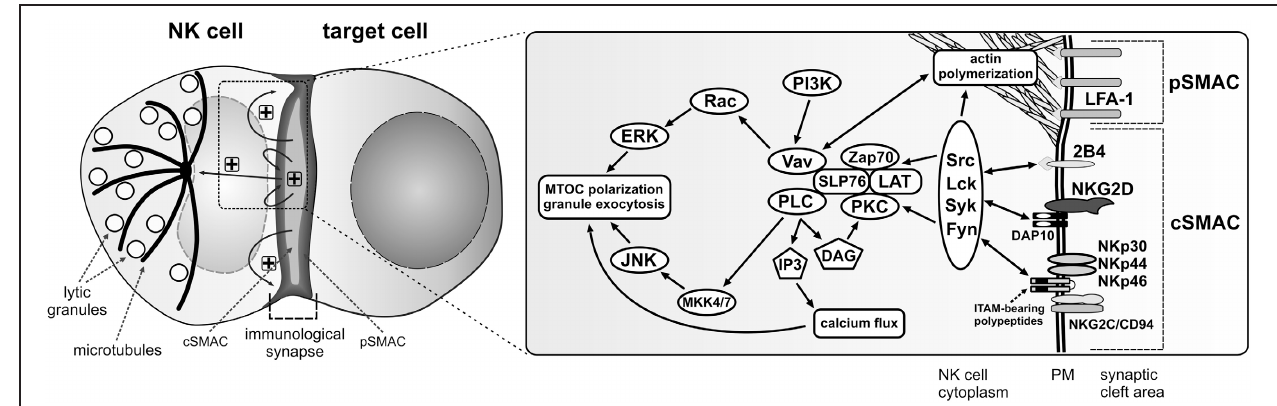
FIGURE 1 | Activation signals for lytic granule polarization in NK cells. The encounter between an NK cell and a susceptible target cell results in conjugation and formation of the activating immunological synapse. Adhesion molecules, such as LFA-1, segregate into the outer region of the synapse, referred to as the peripheral supramolecular activation cluster (pSMAC), while NK cell activating receptors localize into the central area of the synapse (cSMAC). Engagement of NK cell activating receptors by their ligands on the target cell (not shown) induces phosphorylation of membrane proximal